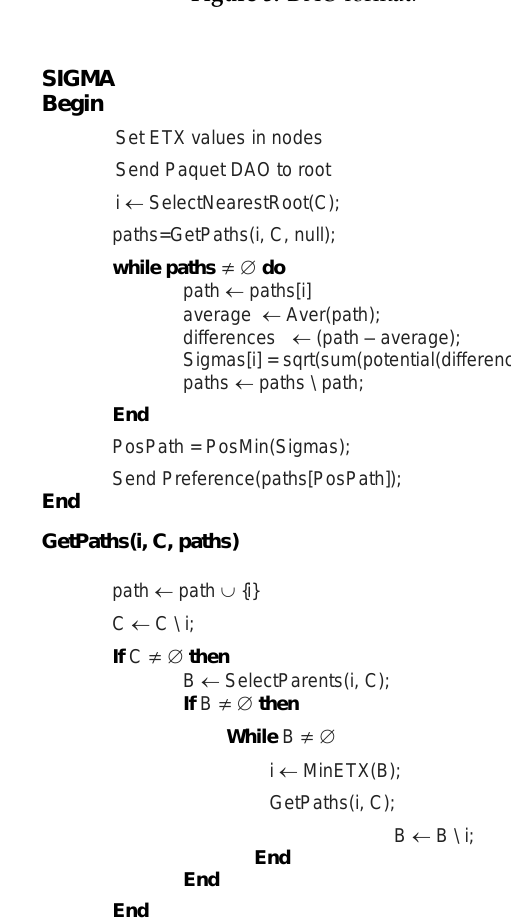
Figure 5. DAO format.